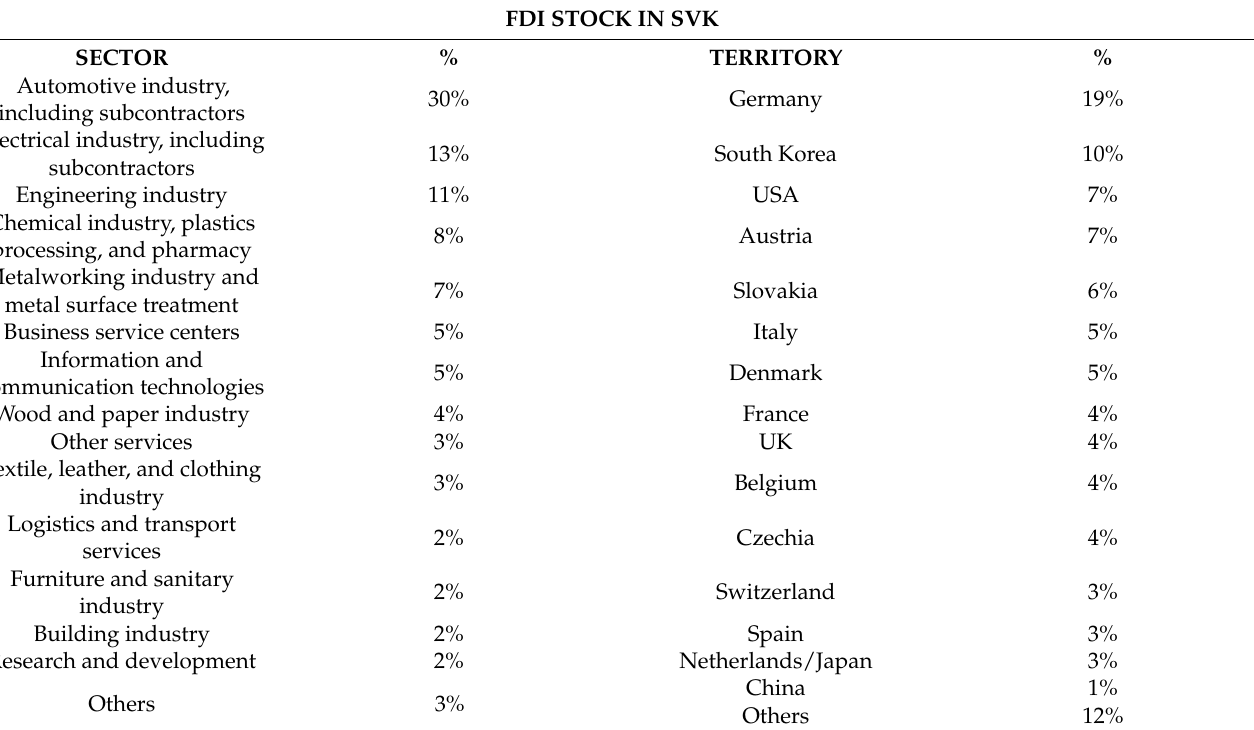
Table 2. FDI stock by sector and territorial structure